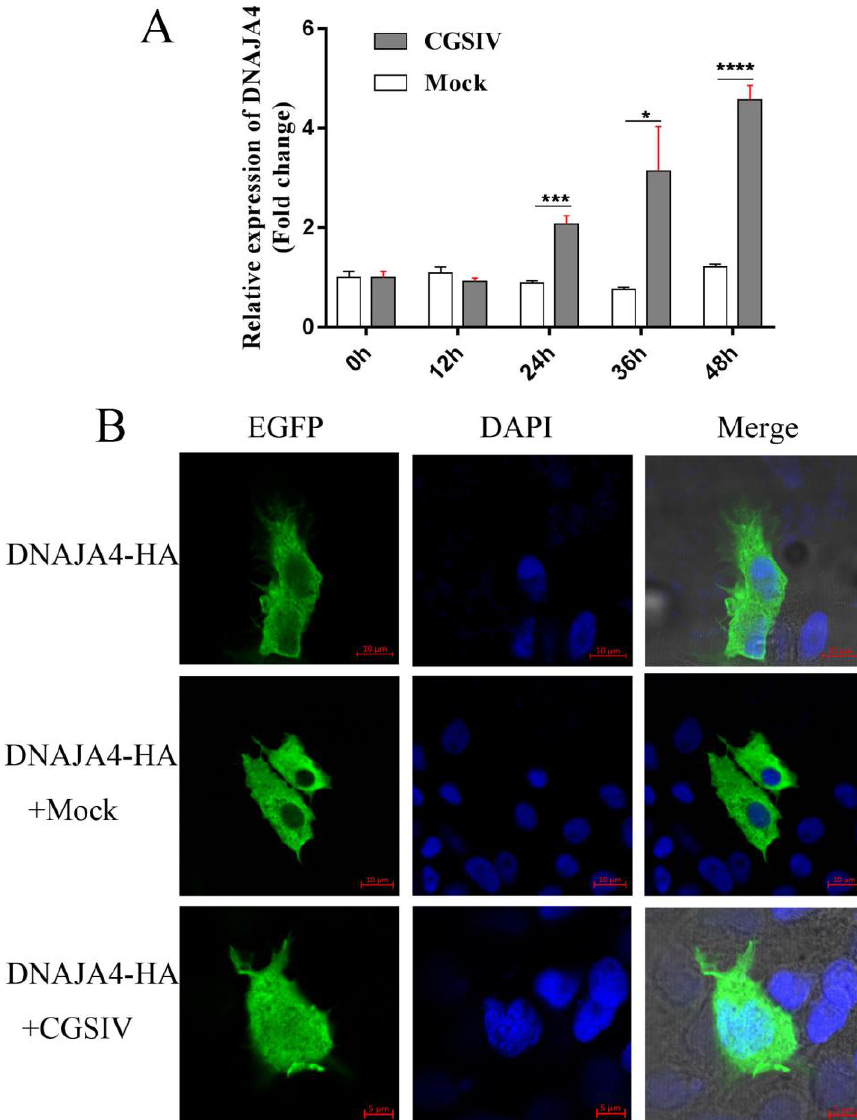
Figure 3. Viral infection affected the expression and localization of EPC DNAJA4. ( A ) Effect of viral infection on EPC DNAJA4 transcription levels; ( B ) effects of viral infection on the localization of EPC DNAJA4. The results were expressed as mean ± SD, ( n = 3; * p < 0.05; *** p < 0.001; **** p < 0.0001)